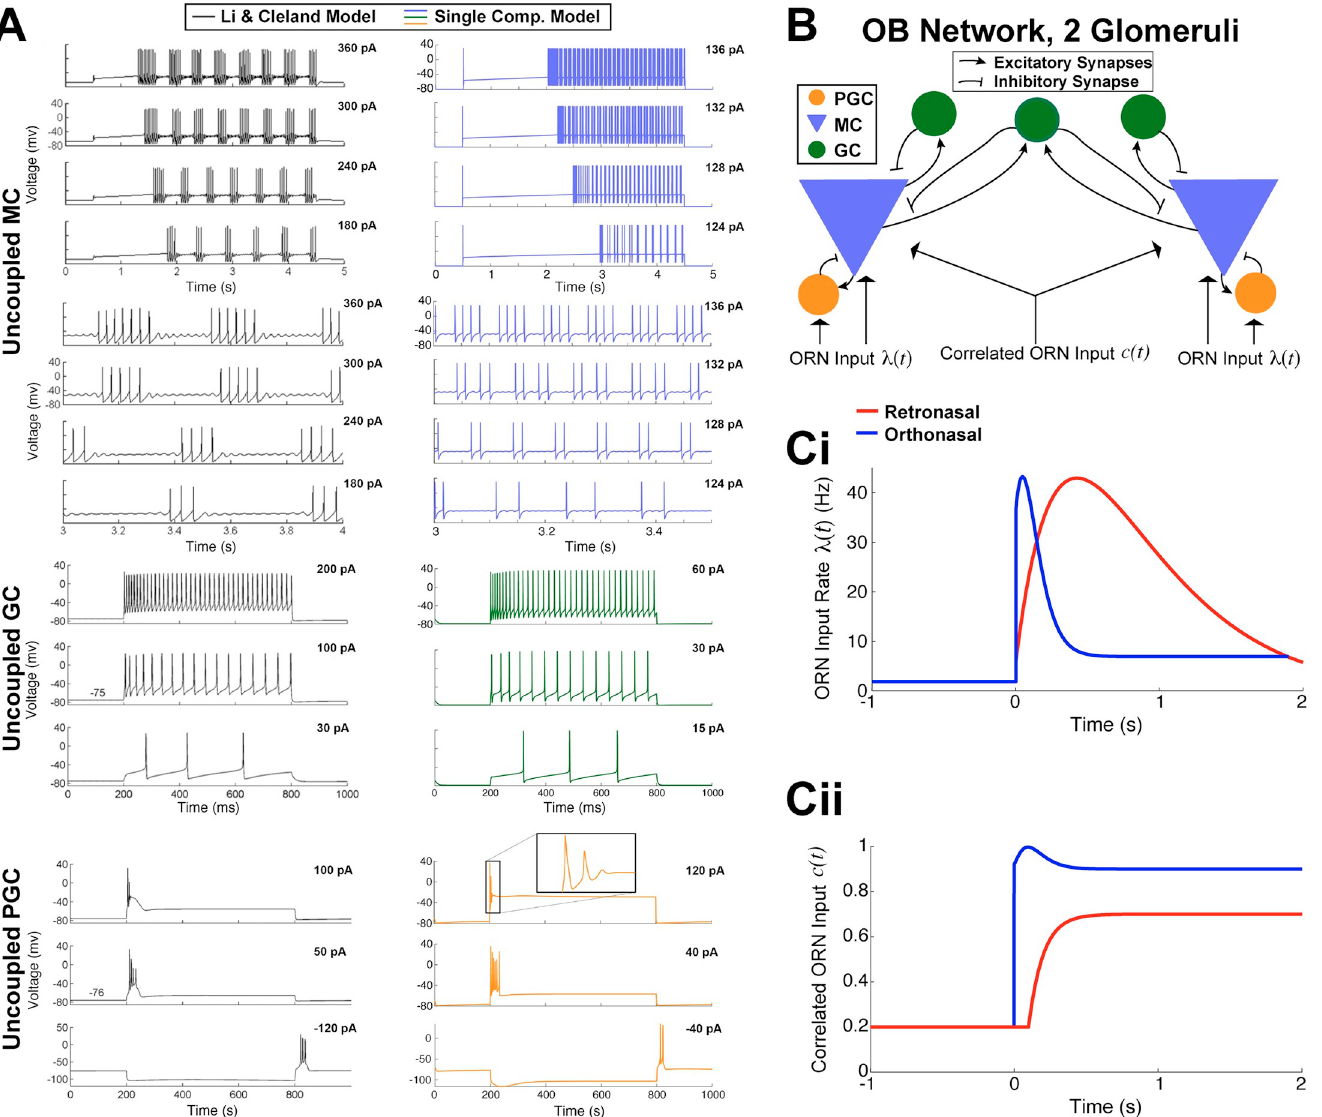
Fig 2. Biophysical OB model. A) Dynamics of the 3 uncoupled cell models. MC voltage dynamics with current step inputs in Li & Cleland models (black curves on the left, copied from Li & Cleland [29]) are captured by our single-compartment model (blue on the right). Rows 5–8 show expanded time view of first 4 rows to highlight spike cluster sizes and sub-threshold oscillations (same voltage axis for each). GC voltage responses to three different levels of current injection in the Li & Cleland model (black curves on the left) is similar to our model (green on the right). PGC responses with depolarizing current steps again are similar in both models. Note that release from a hyperpolarizing current injection leads to transient spiking in both models (bottom). B) Coupled OB network model of 2 glomeruli with ORN inputs. ORN synapses are driven by correlated inhomogeneous Poisson Processes (Eqs (10)–(12)). C) Based on ORN imaging studies, we set λ decay faster than λ R ( t ) with odor onset at time 0s (i). Similarly, we set the input correlation of ORN synapses to the 2 MCs to c R / O ( t ) where c R ( t ) < c O ( t ) and c O ( t ) rises quicker than c ( t ) R